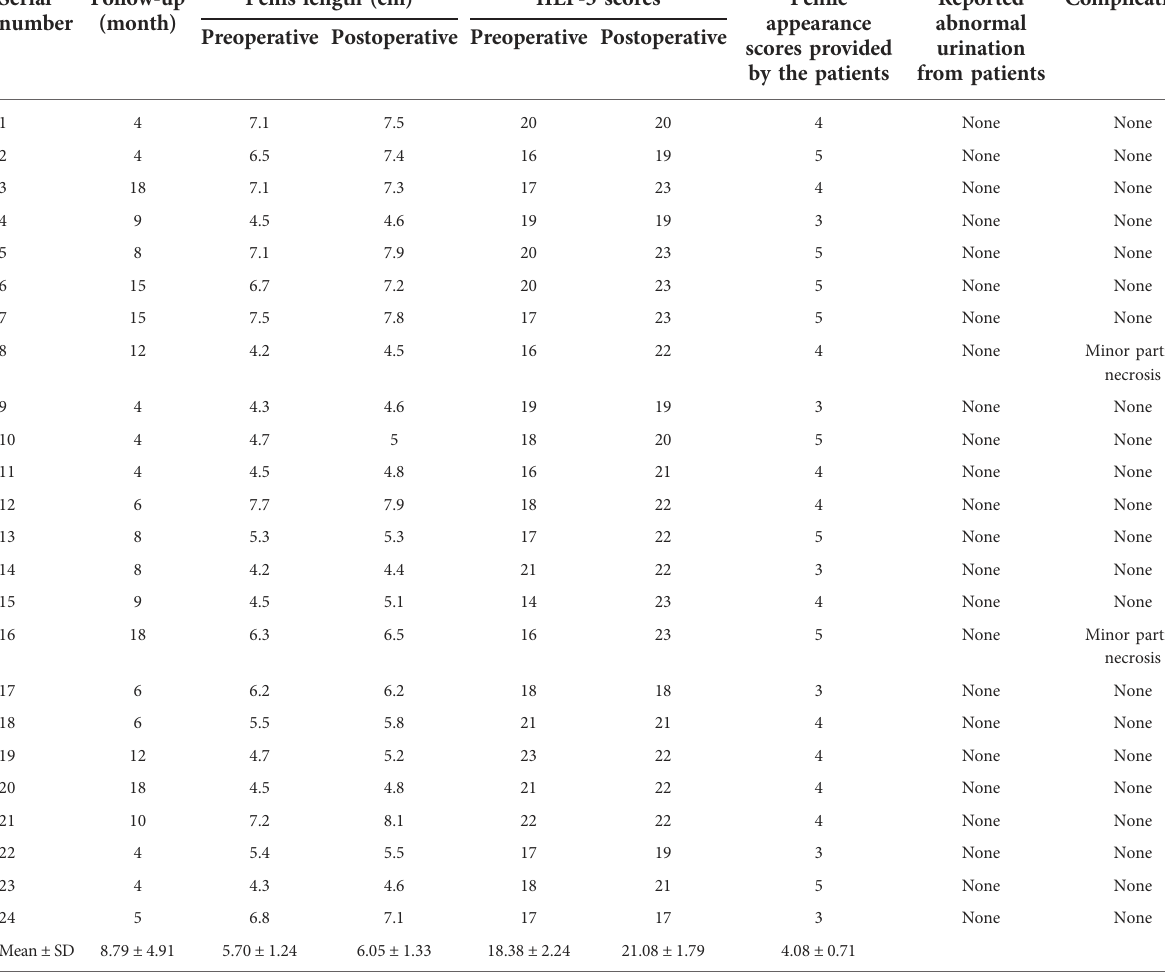
TABLE 1 Postoperative follow-up of the included patients. Serial Follow-up number (month)